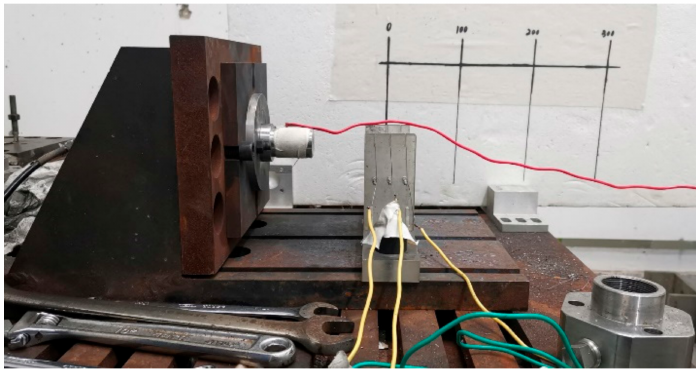
Figure 10. The test tooling of the piston type of measuring device.